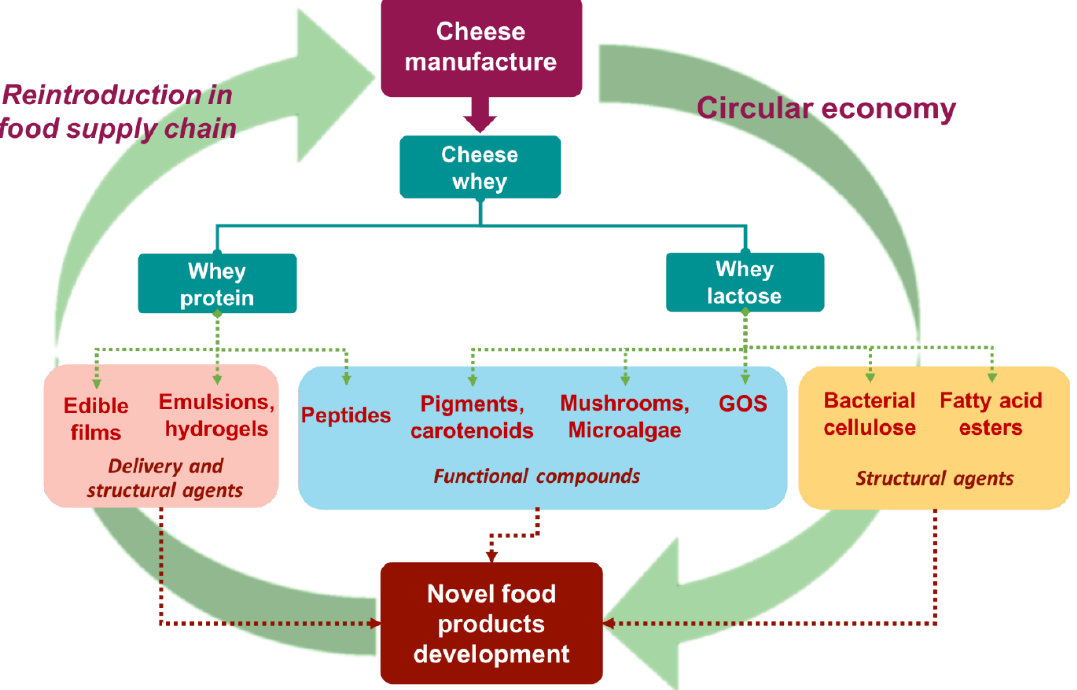
Figure 4. Proposed cheese whey-integrated biorefineries targeting food applications within the circular economy context.